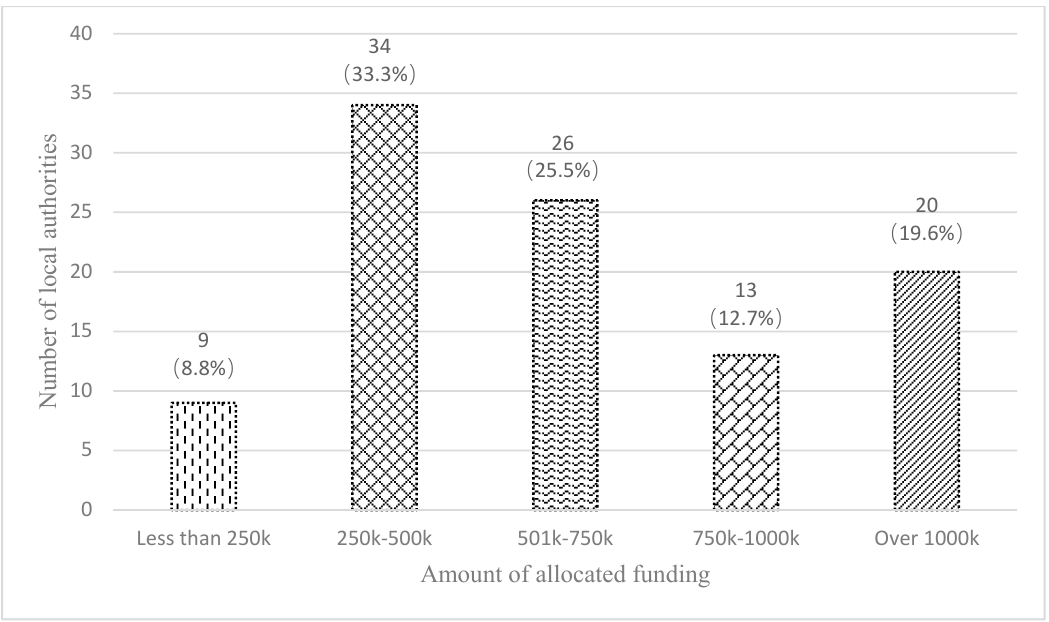
Figure 5. The number of local authorities at different levels of spending.